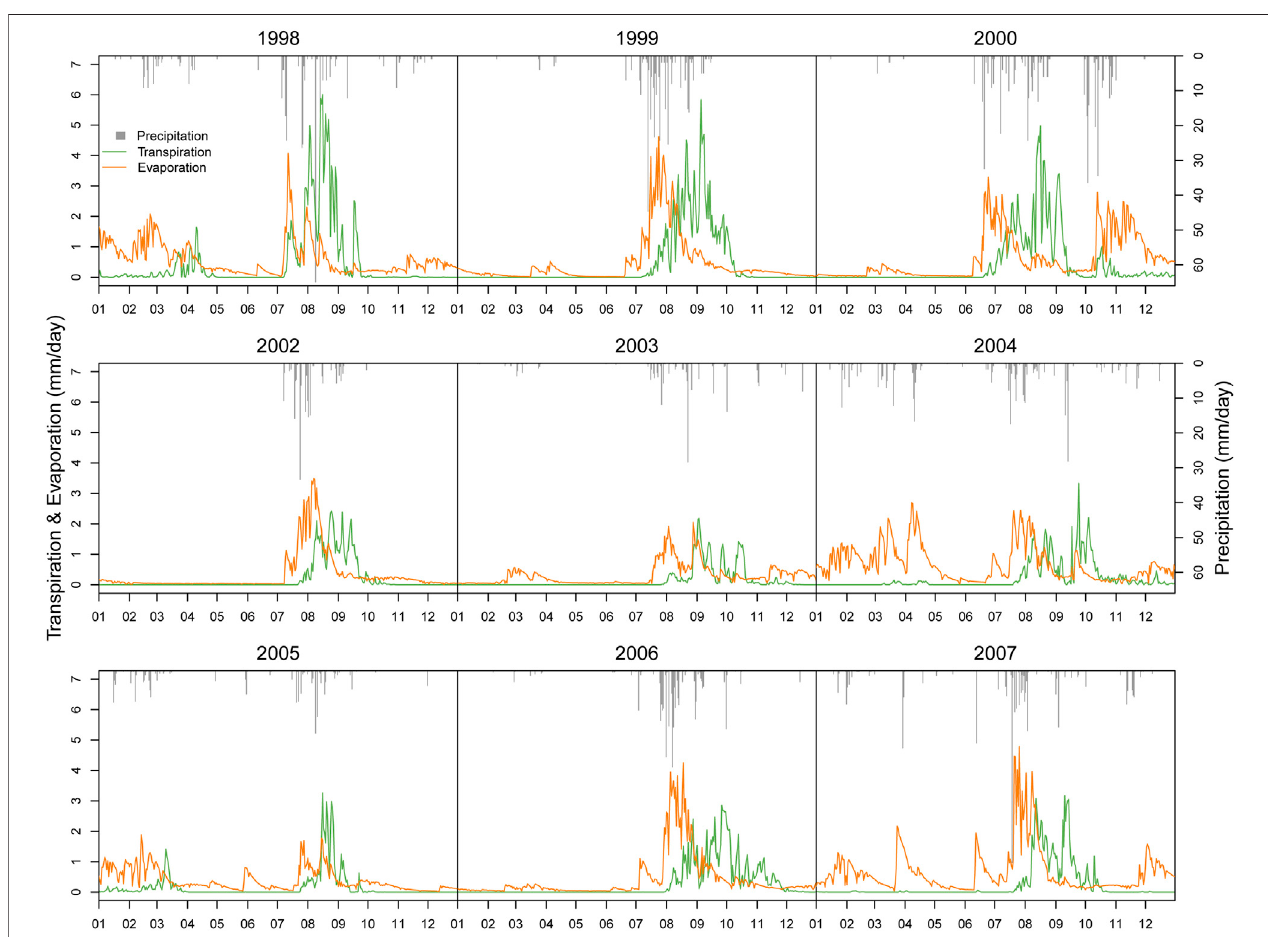
FIGURE 7 | Comparison of simulated soil evaporation and